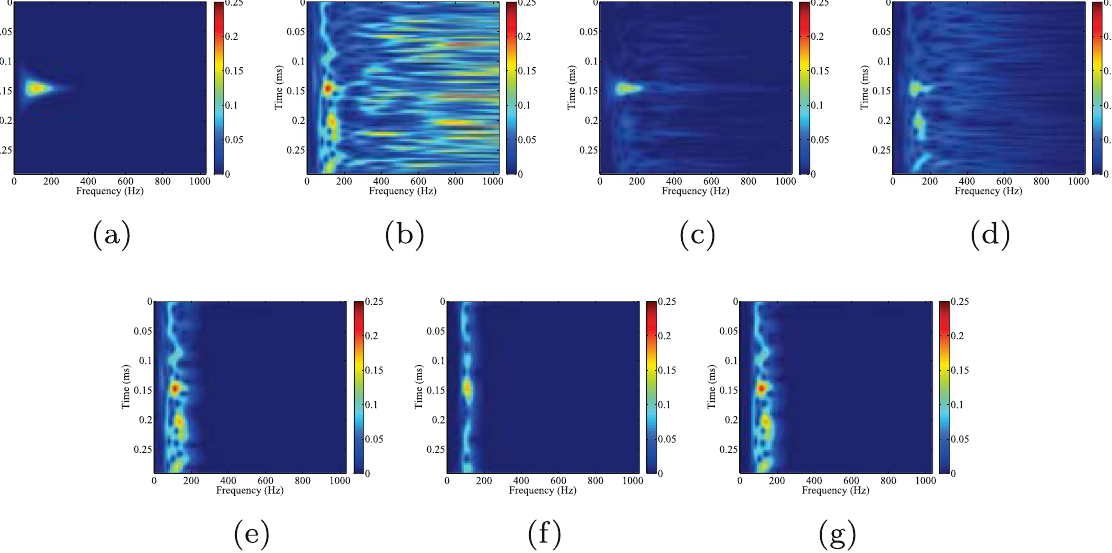
Figure 7. Comparison of time-frequency spectrums of ( a ) clean data, ( b ) noisy data, ( c ) orthogonalized morphological reconstruction, ( d ) conventional morphological reconstruction, ( e ) filtered data (10–20–180–